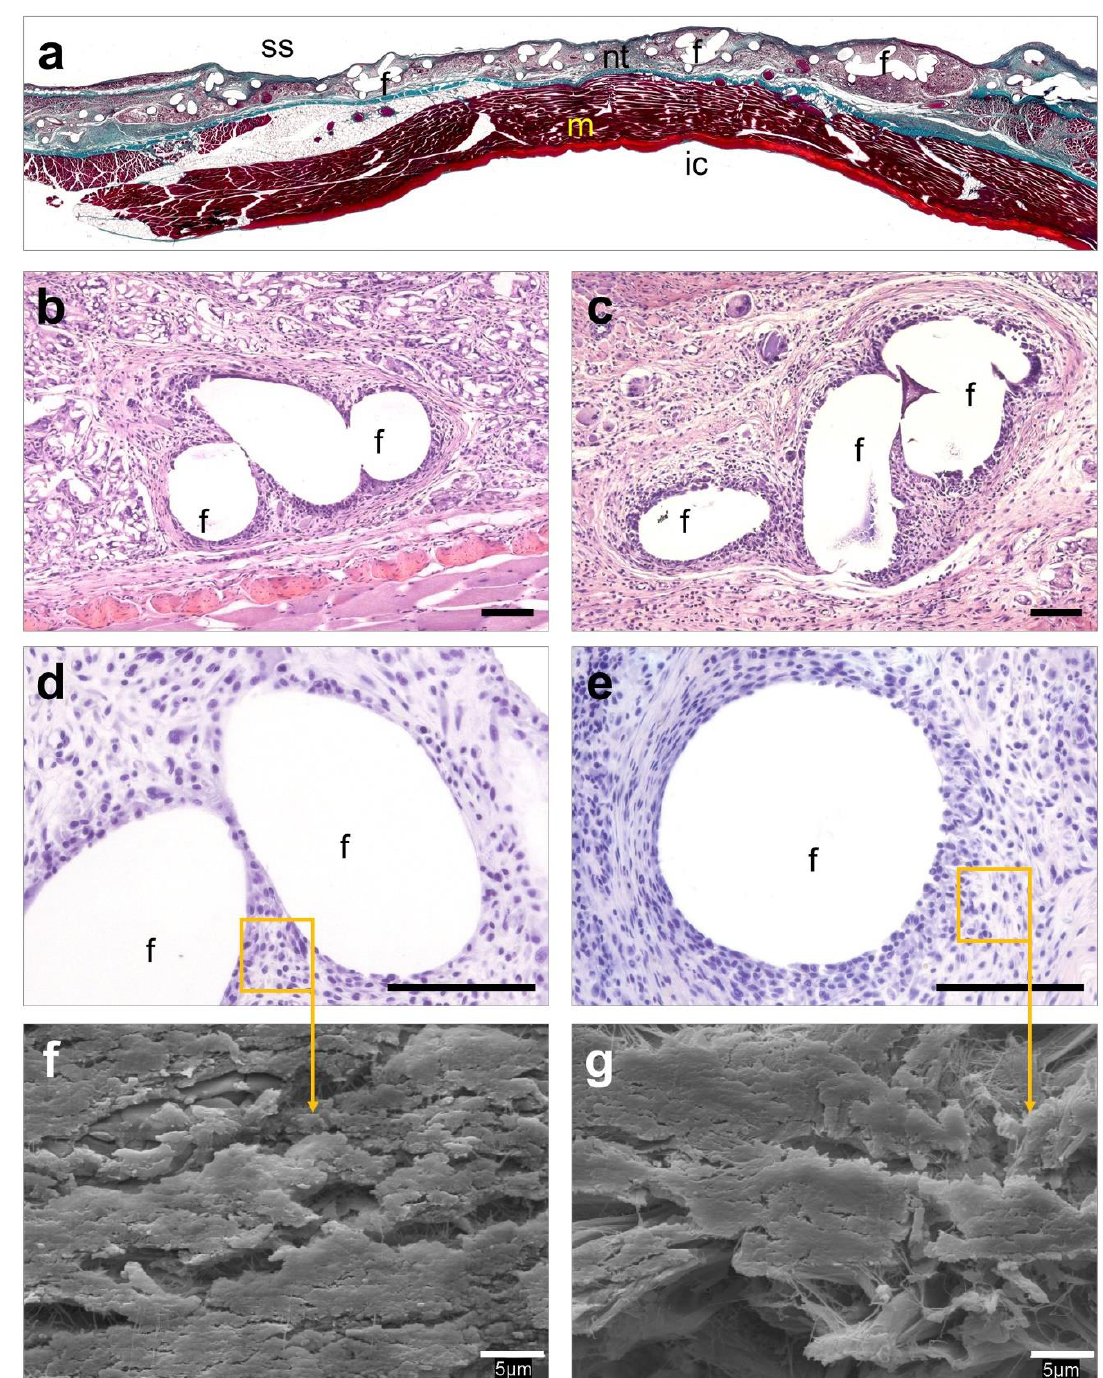
Figure 6. Histological evaluation of the Rif-HApN implants. ( a ) Panoramic view of an implant revealing adequate tissue integration (Masson’s trichrome, ×50). ( b , c ) Detail of different areas of the implant showing a loose neoformed connective tissue surrounding the mesh filaments with no evidence of infection (hematoxylin eosin, ×100). ( d , e ) No living bacteria were recorded throughout the implant (Sa immunostaining, ×320). ( f , g ) Scanning electron microscopy (SEM) visualization confirmed the absence of bacteria in these implants (SEM, ×2000). Symbols: (ic) intraperitoneal cavity; (f) mesh filaments; (m) muscle; (nt) neoformed tissue; (ss) subcutaneous side. Scale bars represent 100 µm (b–e) and 5 µm (f,g).